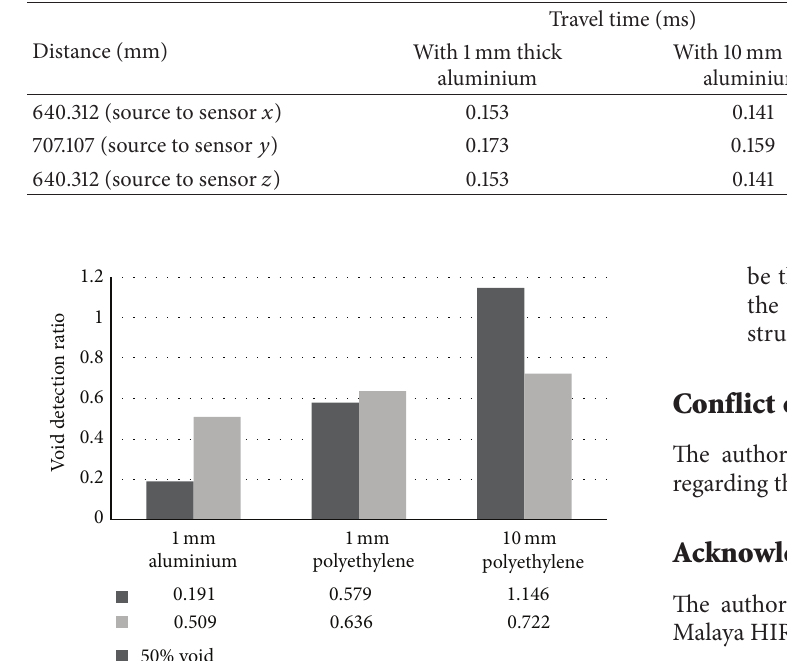
Table 1: Set of travel time from source to sensors at locations “ 𝑥 ”, “ 𝑦 ”, and “ 𝑧 ”.